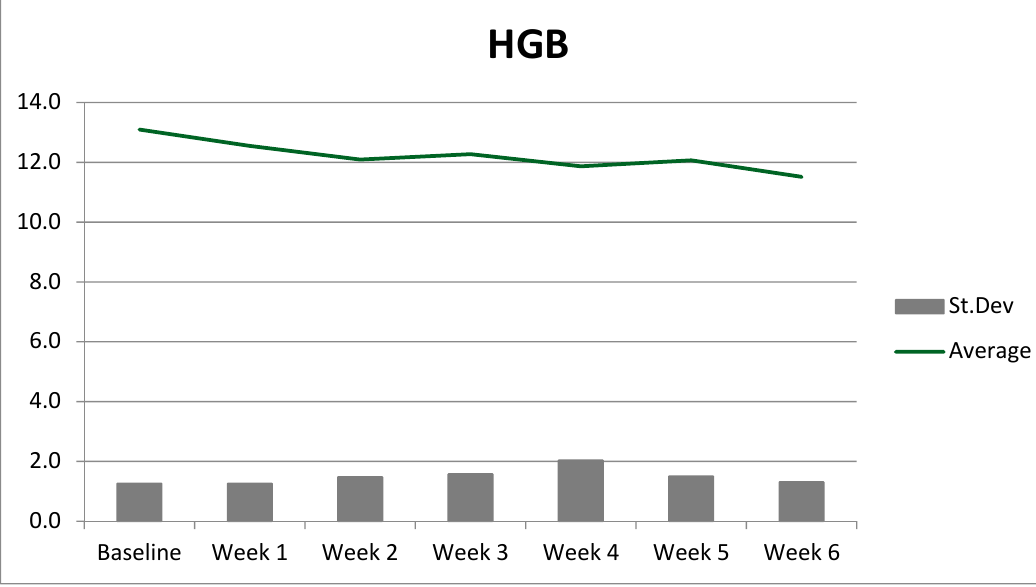
Figure A4. Hemoglobin level trend during treatment.